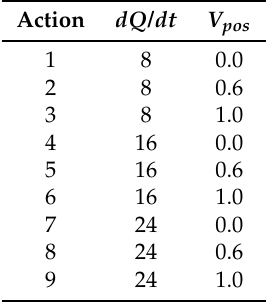
Table 1. Combinations of the heat and steam valve of each action.